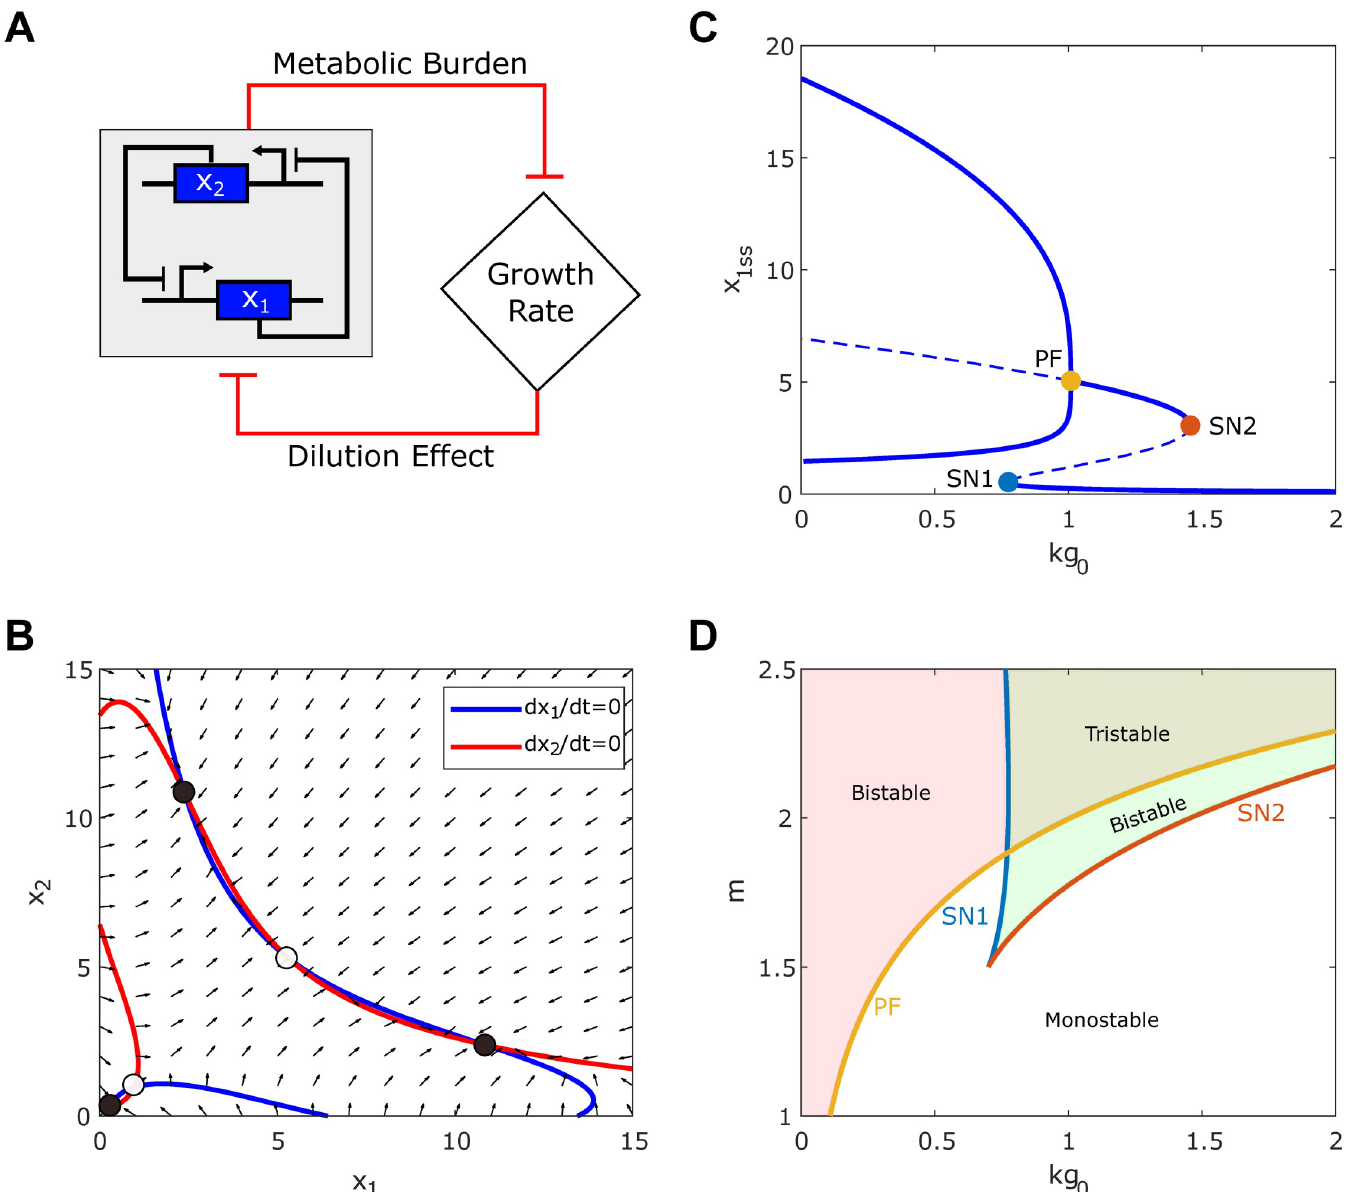
Fig 4. Tristability appears in the synthetic toggle switch circuit under the ultrasensitive growth feedback. (A) Diagram of interaction between the toggle switch circuit and growth rate. (B) Nullcline analysis shows the emergence of tristability. Red and blue lines represent the nullcline ( dx 1 / dt = 0, dx 2 / dt = 0) for x 1 and x 2 , respectively. Solid and open circles represent stable and unstable steady states. Black arrows represent the directional field of the system. (C) The bifurcation diagram of x 1 with respect to kg 0 . Solid and dashed lines correspond to stable and unstable steady state points. Solid circles denote the saddle-nodes (blue and orange for SN1-2, respectively) and pitchfork bifurcation point (yellow for PF). (D) Two-parameter bifurcation diagram with respect to m and kg 0 shows the dependence of the saddle-nodes (SN1-2) and pitchfork bifurcation point (PF) on m . SN1 (blue line) and SN2 (orange line) correspond to the saddle-node bifurcation points. Yellow line represents the PF point. The left red region of the blue (SN1) and orange (SN2) lines represents the bistability of the toggle switch circuit. The green region enclosed between the orange lines corresponds to the system bistability due to the growth feedback. Tristability is found where both bistable regions intersect. Fig 4C shows the bifurcation diagram with respect to the kg ( m = 2), where solid and dash 0 lines symbolize a stable and unstable point, respectively. Our analysis reveals the existence of three bifurcations points (solid circle Fig 4C ), two saddle-node (SN) points, and one pitchfork